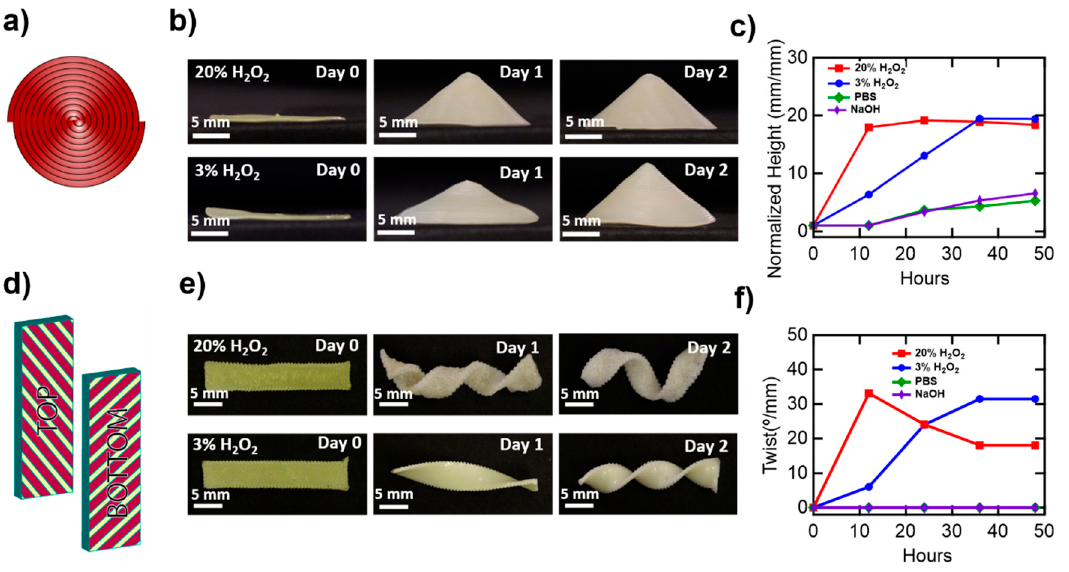
Figure S1: Uniaxial strip after being in an oxidative media for 5 days. Figure S2: E ff ects of degradation on the viscoelastic properties of LCEs in control and hydrolytic solutions. Figure S3: DMA replicates for samples after degrading in 20% H 2 O 2 for 1, 2, and 7 day(s) (n = 3). Figure S4: DMA replicates for samples after degrading in 3% H 2 O 2 for 1, 2, and 7 day(s) (n = 3).